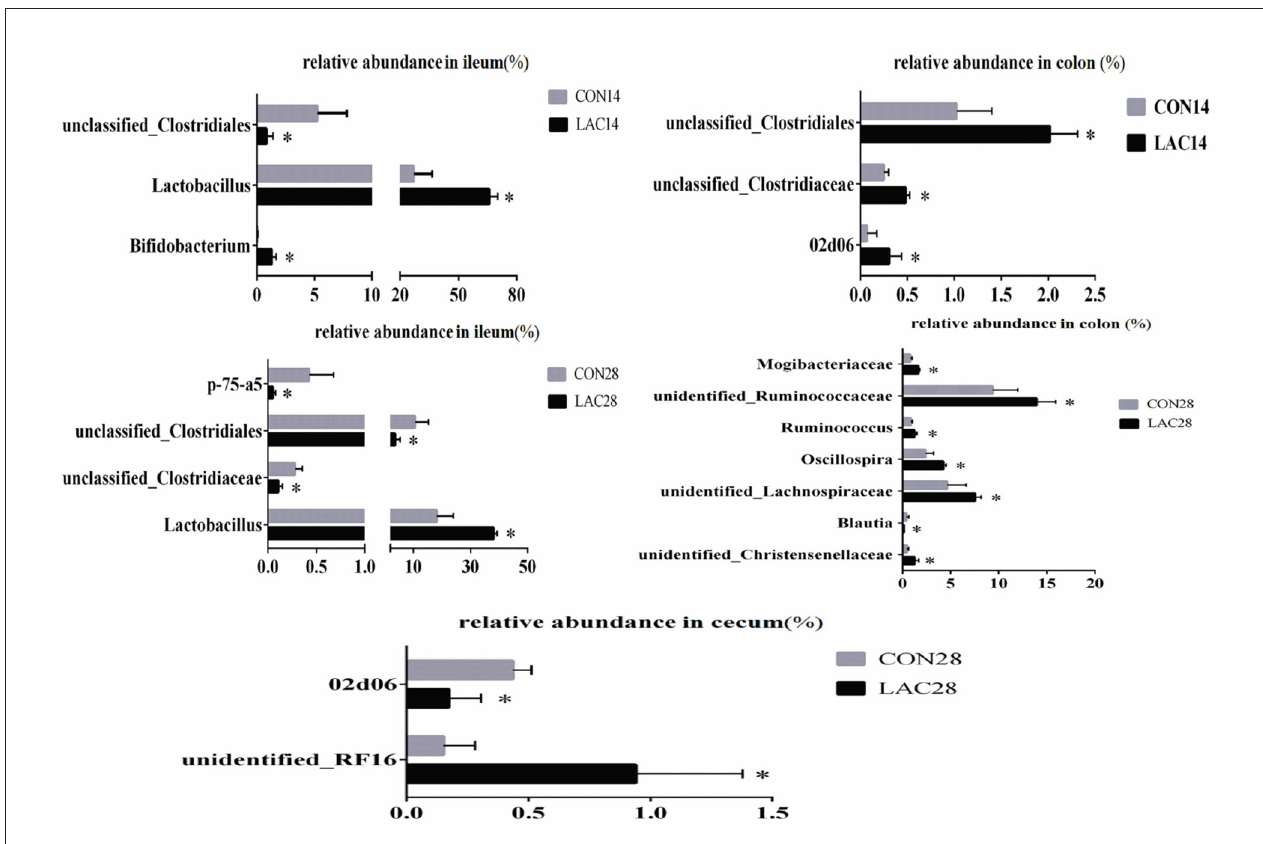
FIGURE 5 | Effects of Lactobacillus delbrueckii on the intestinal bacterial community at the genus level in the weaned piglets. CON, basal diet; LAC, basal diet group with 0.1% Lactobacillus delbrueckii ; 14 and 28 represent the 14 and 28 days of the trial period, respectively. N = 4. Label (*) mean significant difference between the CON group and the LAC group ( p <